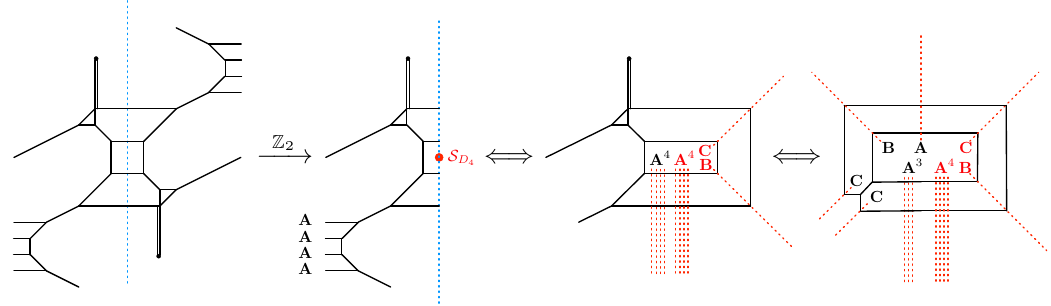
Figure 27 . The Z 2 quotient of 5d SU(4) 0 + 2 AS + 8 F giving rise to a 5-brane configuration for rank-2 E -string on a circle, 5d Sp(2) + 1 AS + 8 F . The inner 5-brane loop contains a 7-brane configuration ( A 7 BCAB ) = ( A 8 BCB ) showing an E